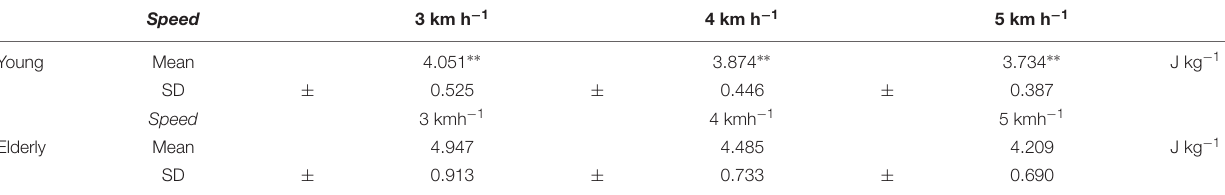
TABLE 1 | Mean values of the energy cost of walking per unit distance (CoT) between the young and elderly groups at three different walking speeds. Speed